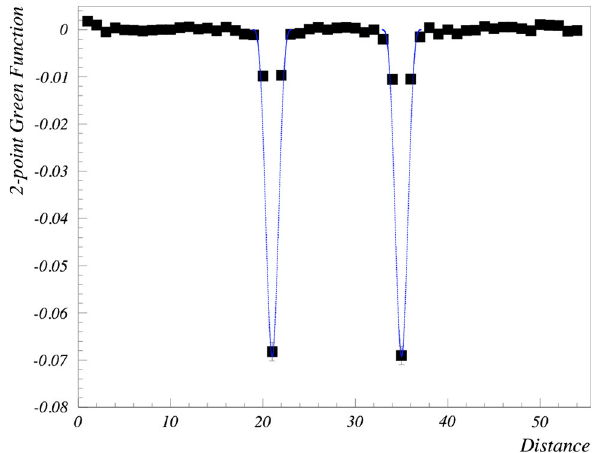
Fig. 3 Comparison between the potential computed numerically using Eq. (1) ( sq u ares ) and the analytical expectation sn ( x , − 1 ) (cid:6) sn ( x , − 1 ) ( line ). The simulation used a coupling g 2 = 3, a lattice size N = 55, N s = 5 × 10 4 configurations, a decorrelation coefficient N cor = 15 and random field boundary conditions